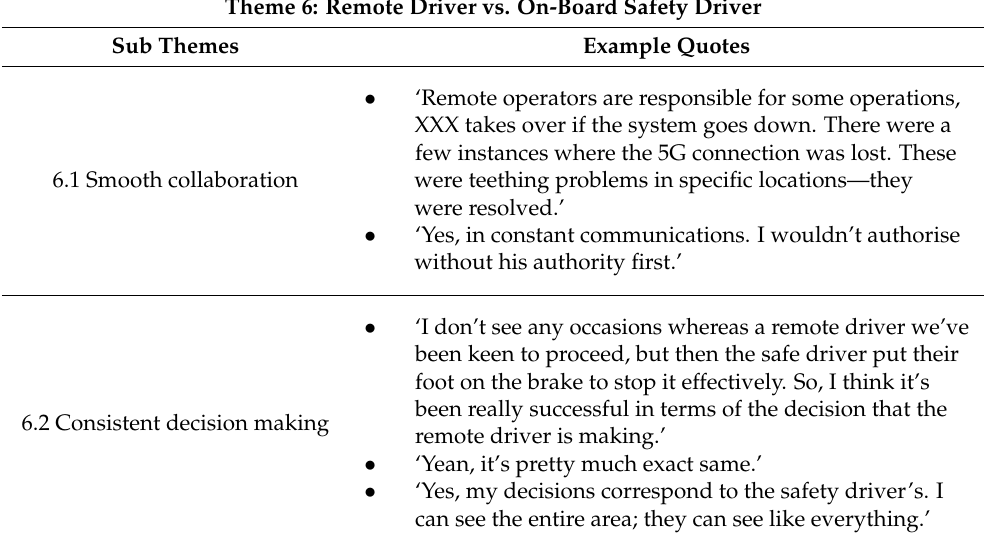
Table 6. Theme 6: Remote driver vs. on-board safety driver. Theme 6: Remote Driver vs. On-Board Safety